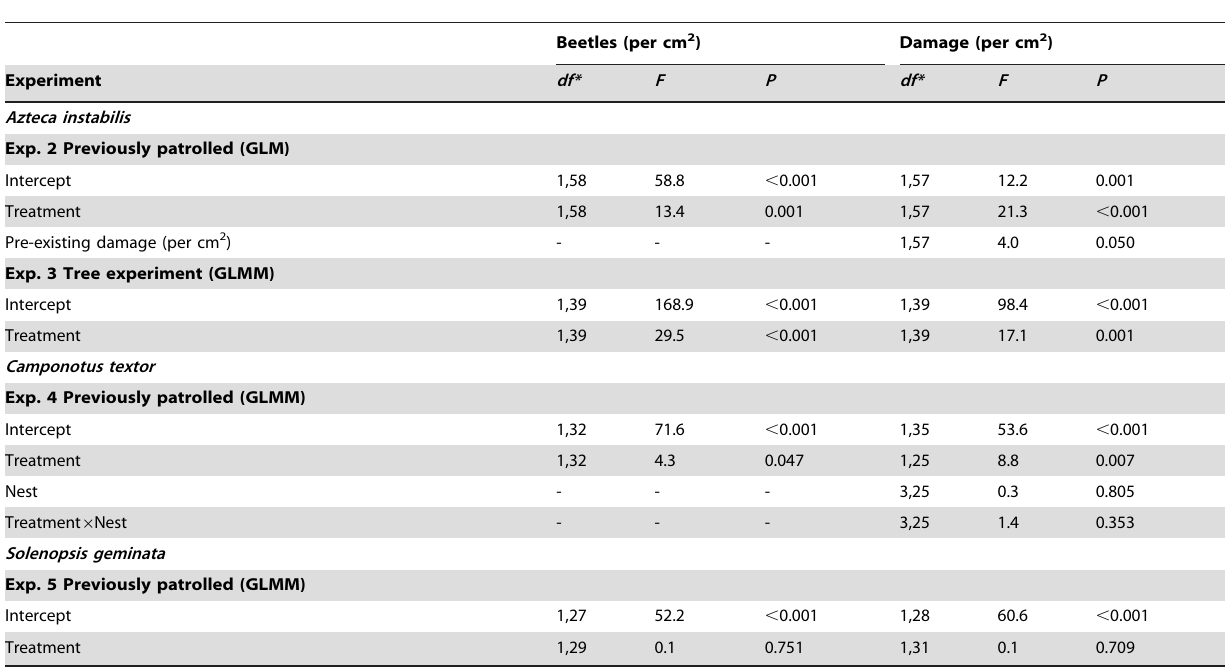
Table 2. The effect of ant semiochemical treatments on beetle choice and herbivory (best-fit models Exp. 2–5) { .